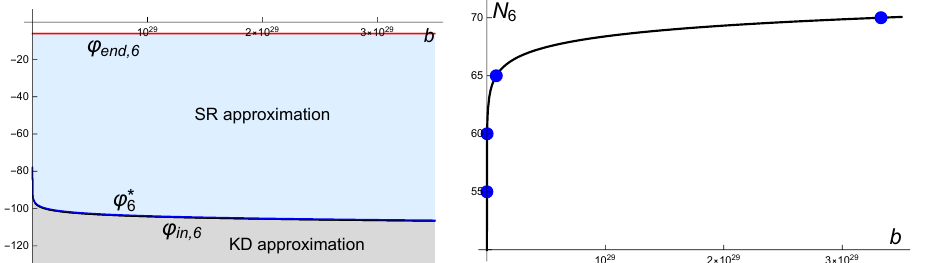
( b ) (blue line), and ϕ end ,6 (red line) 6 √ √ 3 2 , µ = , c 1 = 2 × 10 − 10 , c 2 = 2.5 × 10 − 10 . 3 4 ( b ) is very small by comparison 6 ( b ) and ϕ ( b , ϕ ) plane end ,6 . It also shows the regions in the 6